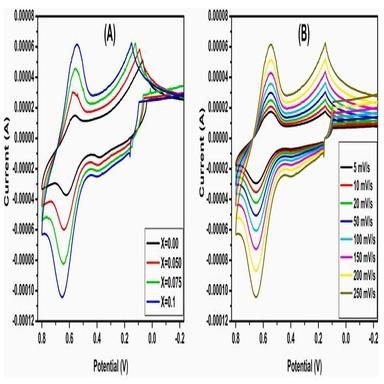
Cyclic voltammograms of CoFe2-xSmxO4 (a) x = 0.0, x = 0.050, x = 0.075 and x = 0.1 ferrite composite (b) Cyclic voltammograms of CoFe2-xSmxO4 at x = 0.1 at different scan rates.